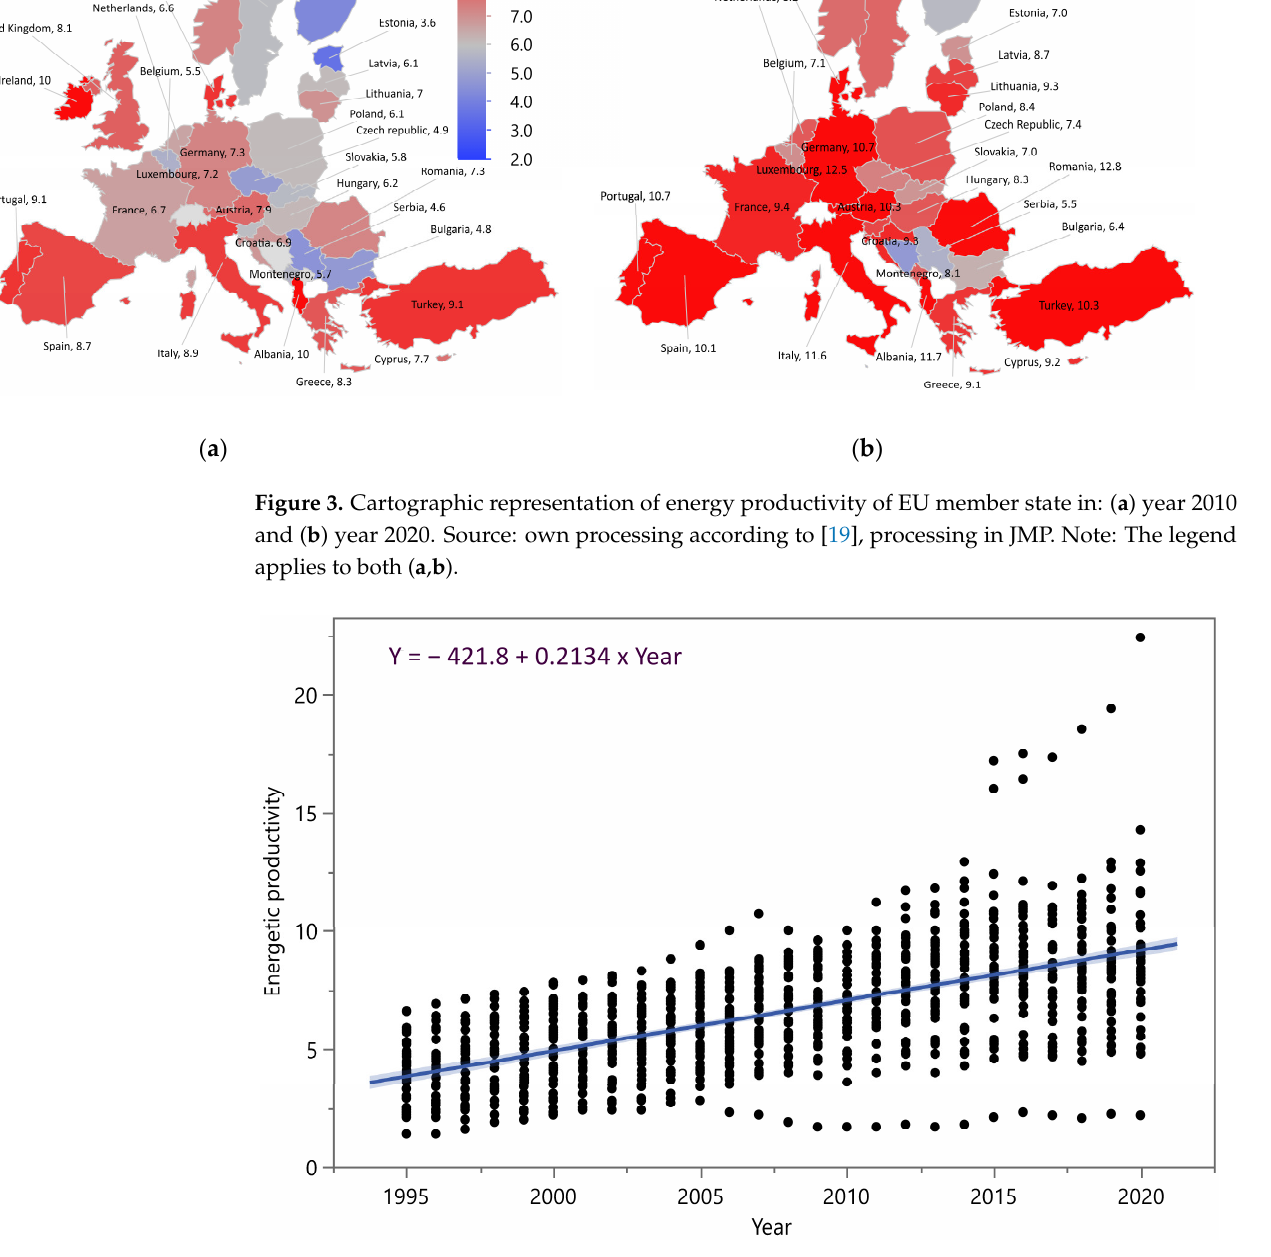
Figure 4. Development of energy productivity in EU in 1995–2016. Source: own processing according to [19], processing in JMP.